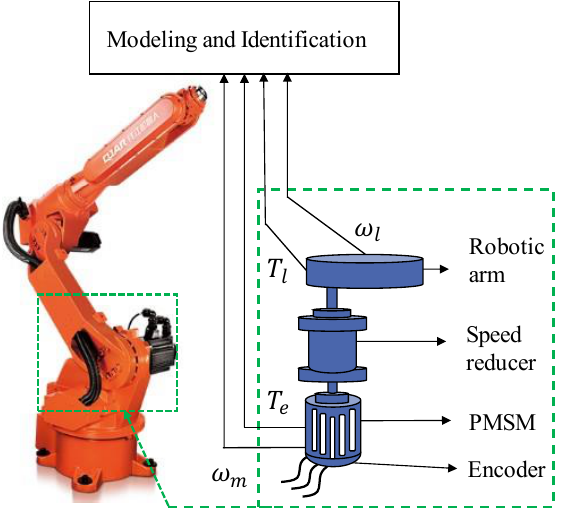
Figure 1. The schematic diagram of a single joint of an industrial robot. The joint structure of the robot is complex. Moreover, identifying each structural parameter is challenging. However, a robot joint can be equivalent to an identifiable dual inertia model. Equations (1) and (2) can be used to calculate the equivalent stiffness and equivalent load inertia of the joint.